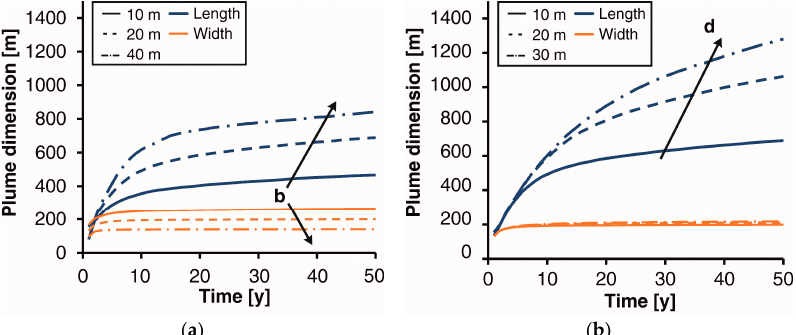
Figure 8. Time evolution of plume dimensions with different values of aquifer thickness b ( a ) and vadose zone thickness d ( b ); isotherm ∆ T = 1 °C.